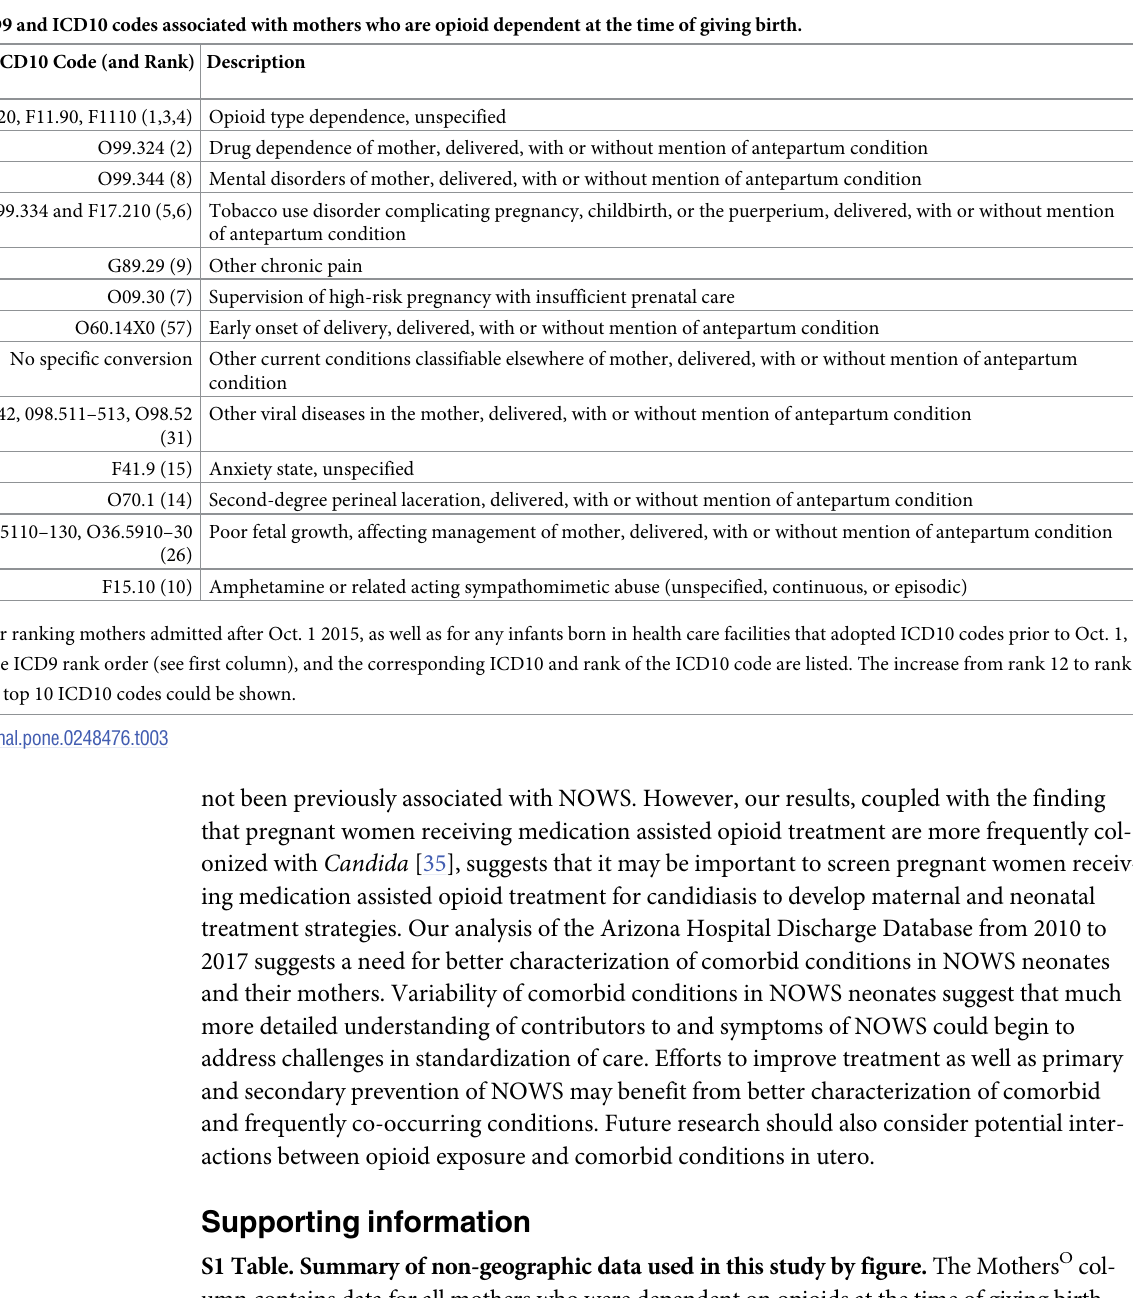
S1 Table. Summary of non-geographic data used in this study by figure. The Mothers O col- umn contains data for all mothers who were dependent on opioids at the time of giving birth. The Infants NOWS column contains data for all infants who had NOWS. Totals at the end of each category are not the same for all categories due to missing data or because some patients reported atypical categories (e.g. payer was workers compensation or individual was a foreign national).